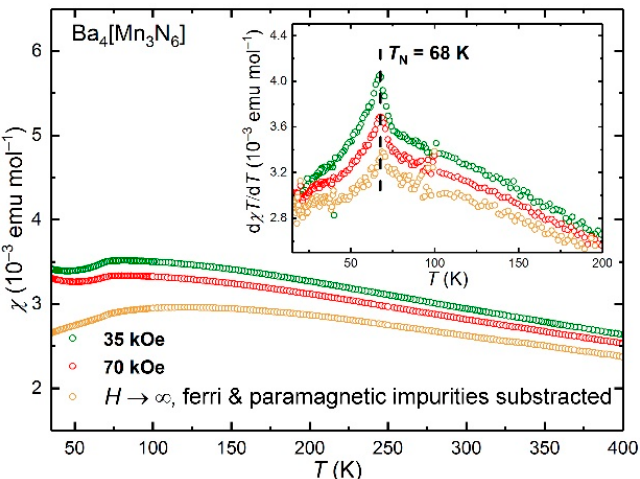
Figure 5. Temperature dependence of magnetic susceptibility for Ba 4 [Mn 3 N 6 ] up to 400 K measured in different fields. Inset: d χ T /d T ( T ) plot emphasizing the AFM transition.